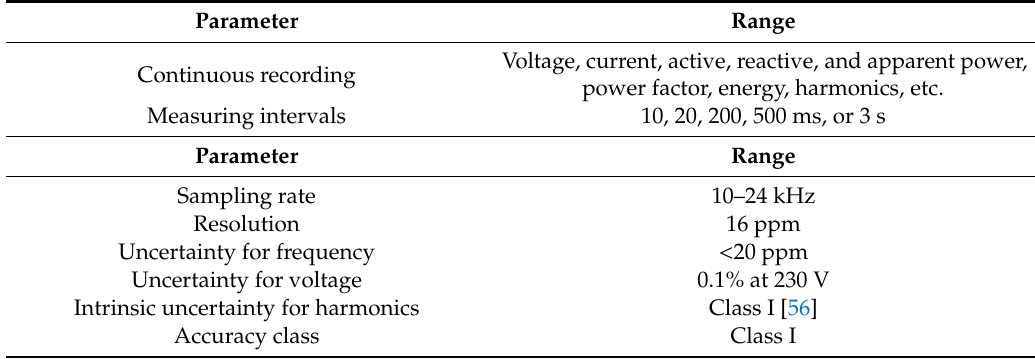
Table 1. Main features of electrical RMS and model Fluke